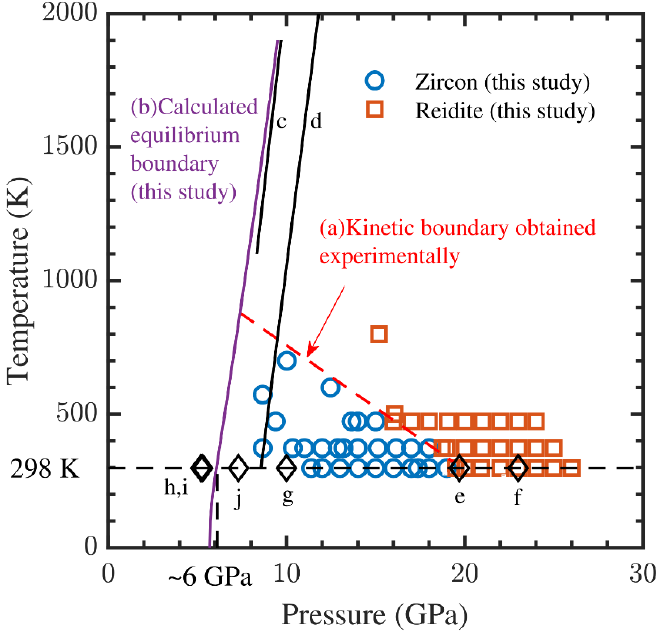
Figure 6. Experimental and computational high P–T results for the zircon–reidite phase transition. The blue circles and orange squares represent the stable domains of zircon and reidite, respectively. Abbrevia- tions are as follows: (a) the kinetic phase boundary determined by linear fit of our experiments results; (b) the equilibrium phase boundary calculated at 298 to 1900 K by DFT in this study; (c) the